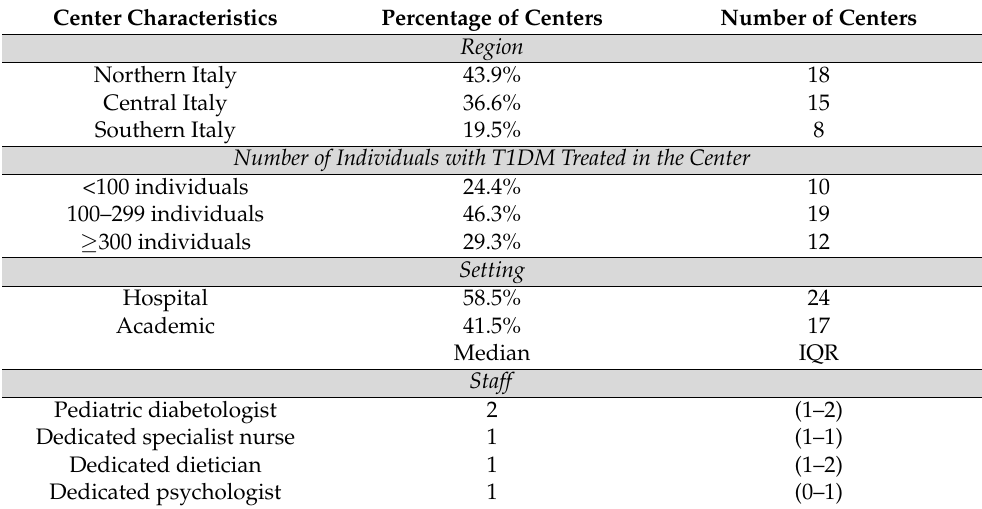
Table 1. Survey center